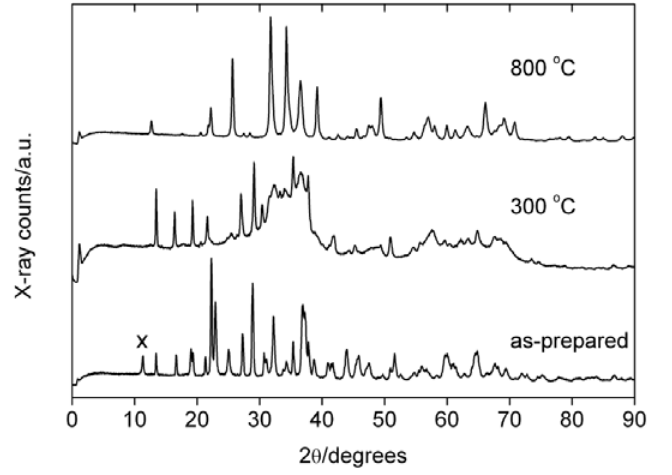
Figure 1 . XRD patterns of a precipitate obtained after 30 hours of reaction time and the same sample after calcination at 300 and 800 ºC, respectively. (x) denotes the γ -Zn(OH) 110